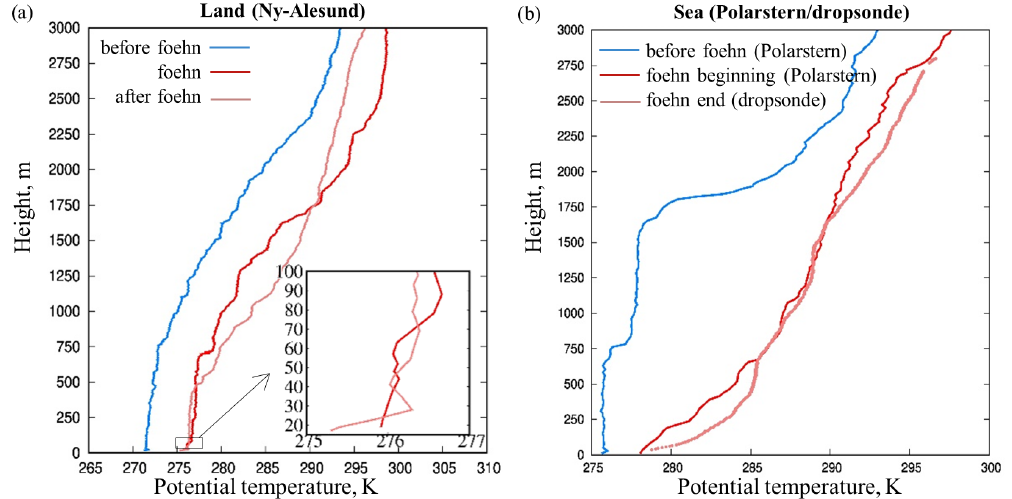
Figure 8. Observations of potential temperature in the lower troposphere (a) over land (Ny-Ålesund) and (b) over sea. (a) Radiosonde obser- vations over Ny-Ålesund before foehn onset (12:00UTC, 29 May), during foehn (12:00UTC, 30 May) and after foehn episode (12:00UTC, 1 June). The lowermost 100m layer is enlarged (see inset). (b) Polarstern radiosonde observations at 11:00, 30 May (south from Spitsber- gen) and at 04:34, 31 May, and dropsonde observations at 18:21, 31 May. The latter two observations were taken in front of northwestern Spitsbergen, at the beginning and at the end of foehn episode,